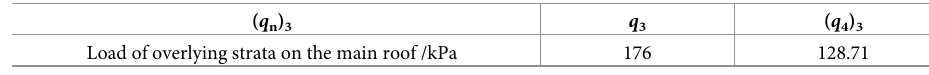
Table 14. A load of overlying strata on the main roof of No.5 coal seam.